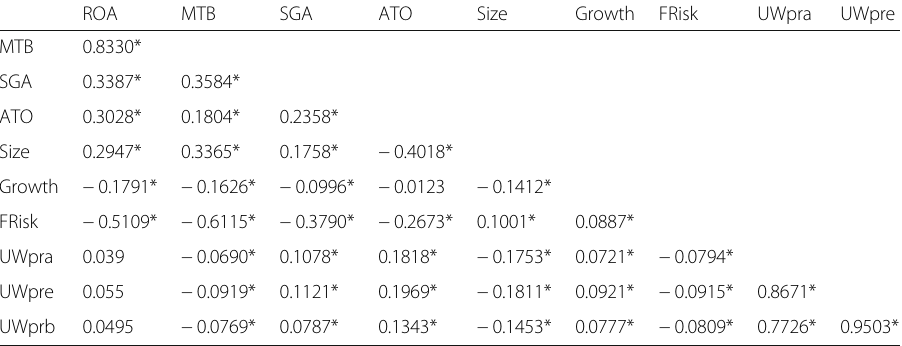
Table 3 Spearman correlation coefficients